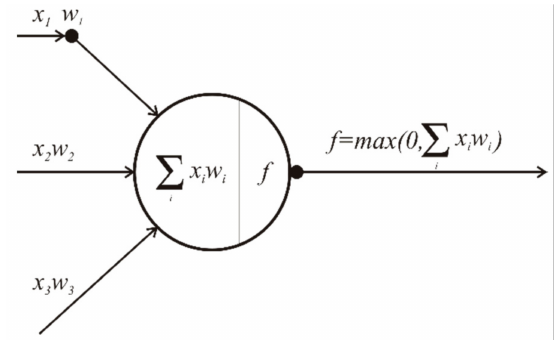
Figure 9. Artificial